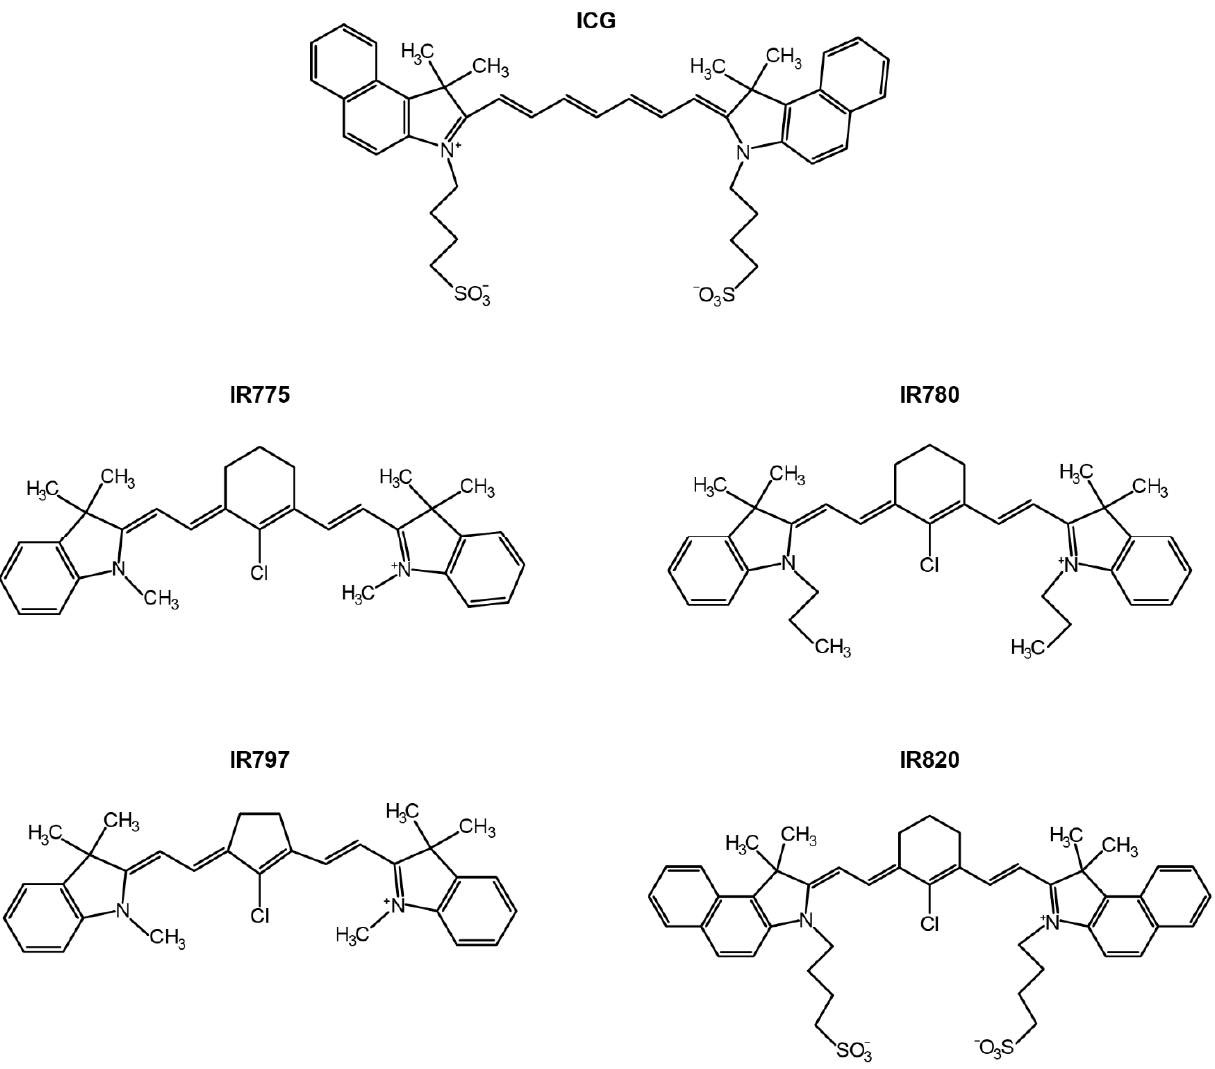
Figure 1. Chemical structure of the HCs (ICG, IR775, IR780, IR797, and IR820) that have been encapsulated in nanomaterials for application in cancer immuno-PTT/PDT.